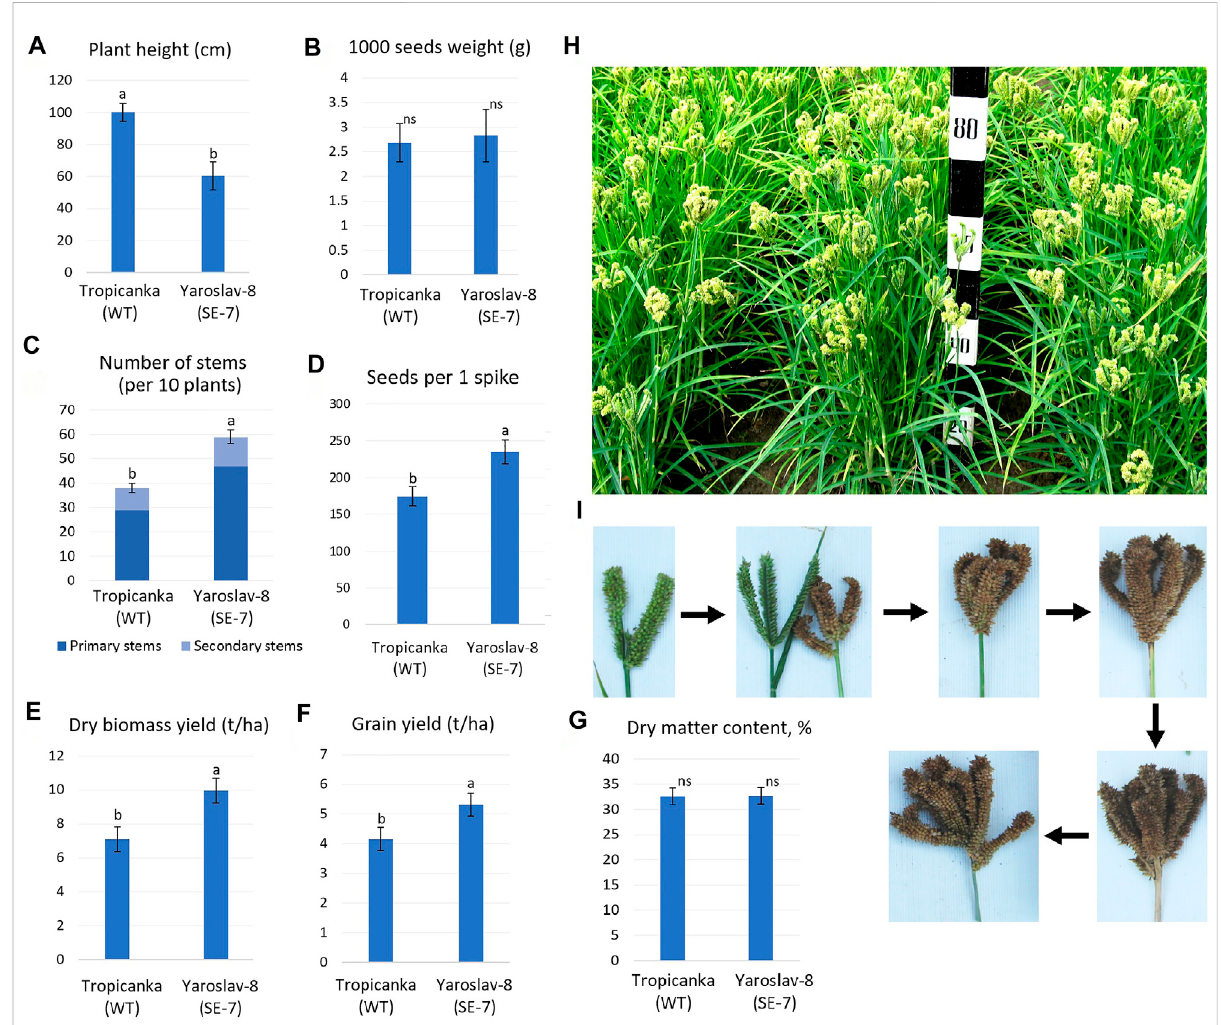
FIGURE 9 Performance of the SE7 mutant line in comparison with the WT during fi eld trials. (A – D) , (G) — measurements of different productivity traits; (E,F) — grainand biomass yield; (H) — plants oftheSE7 line during maturation; (I) — differentstages of fi nger millet panicle maturation.Different letters within each parameter (A – G) : a, b — signi fi cantly different values; ns — difference not signi fi cant (at p < 0.05, Fischer